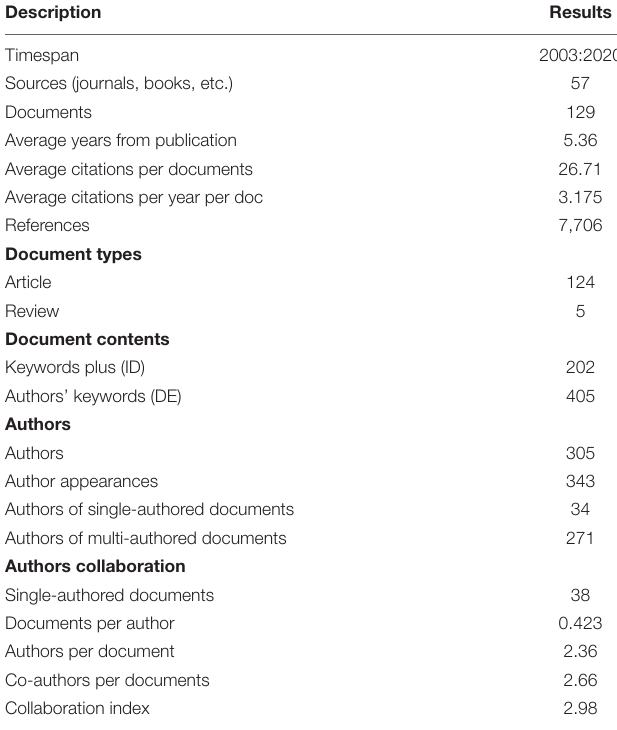
TABLE 1 | Summary of the main information of the dataset